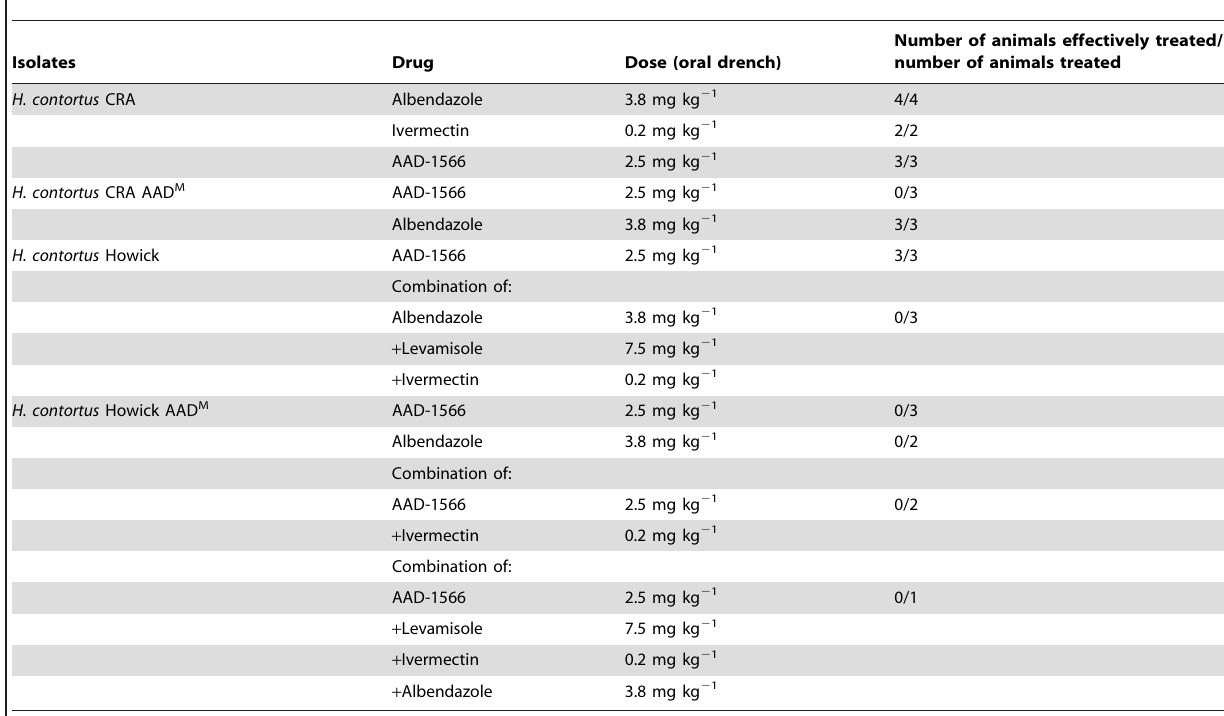
Table 1. In vivo sensitivity of adult stages of H. contortus CRA, CRA AAD M , Howick and Howick AAD M .